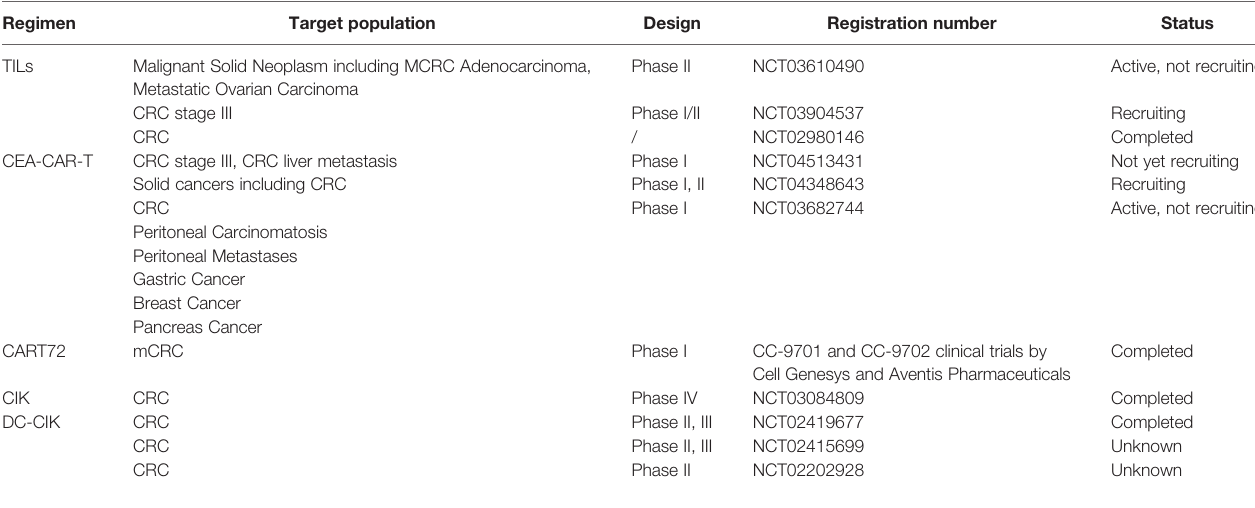
TABLE 4 | Summary of adoptive cell therapy (ACT) for colorectal cancer (CRC).